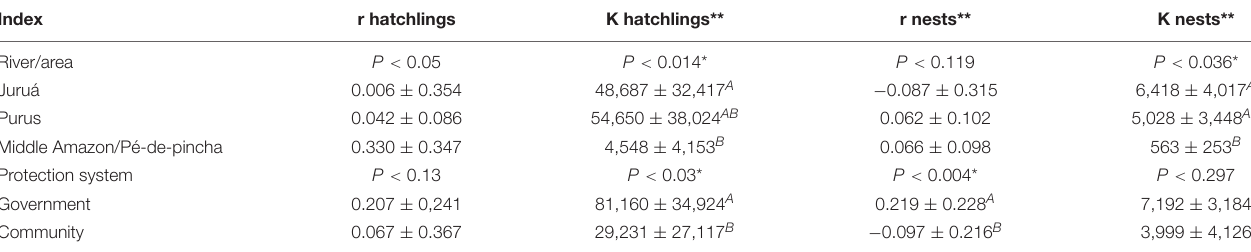
FIGURE 11 | Comparison between the trend lines of the production of nests of P. expansa and P. unifilis : (A) Manariã beach, middle Juruá; (B) Joanico beach, lower Juruá. TABLE 3 | Summary of the ANOVA of instantaneous growth rates (r) and carrying capacity (K) for number of nests/reproductive females and hatchlings of Podocnemis sextuberculata . Index r hatchlings K hatchlings** r nests** K